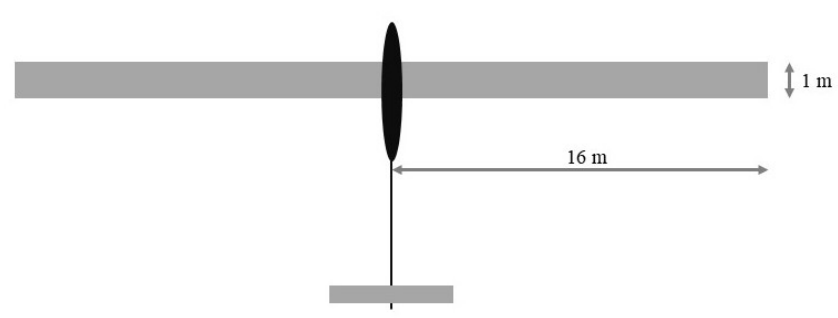
Figure 3. Geometric representation of high altitude long endurance unmanned air vehicle